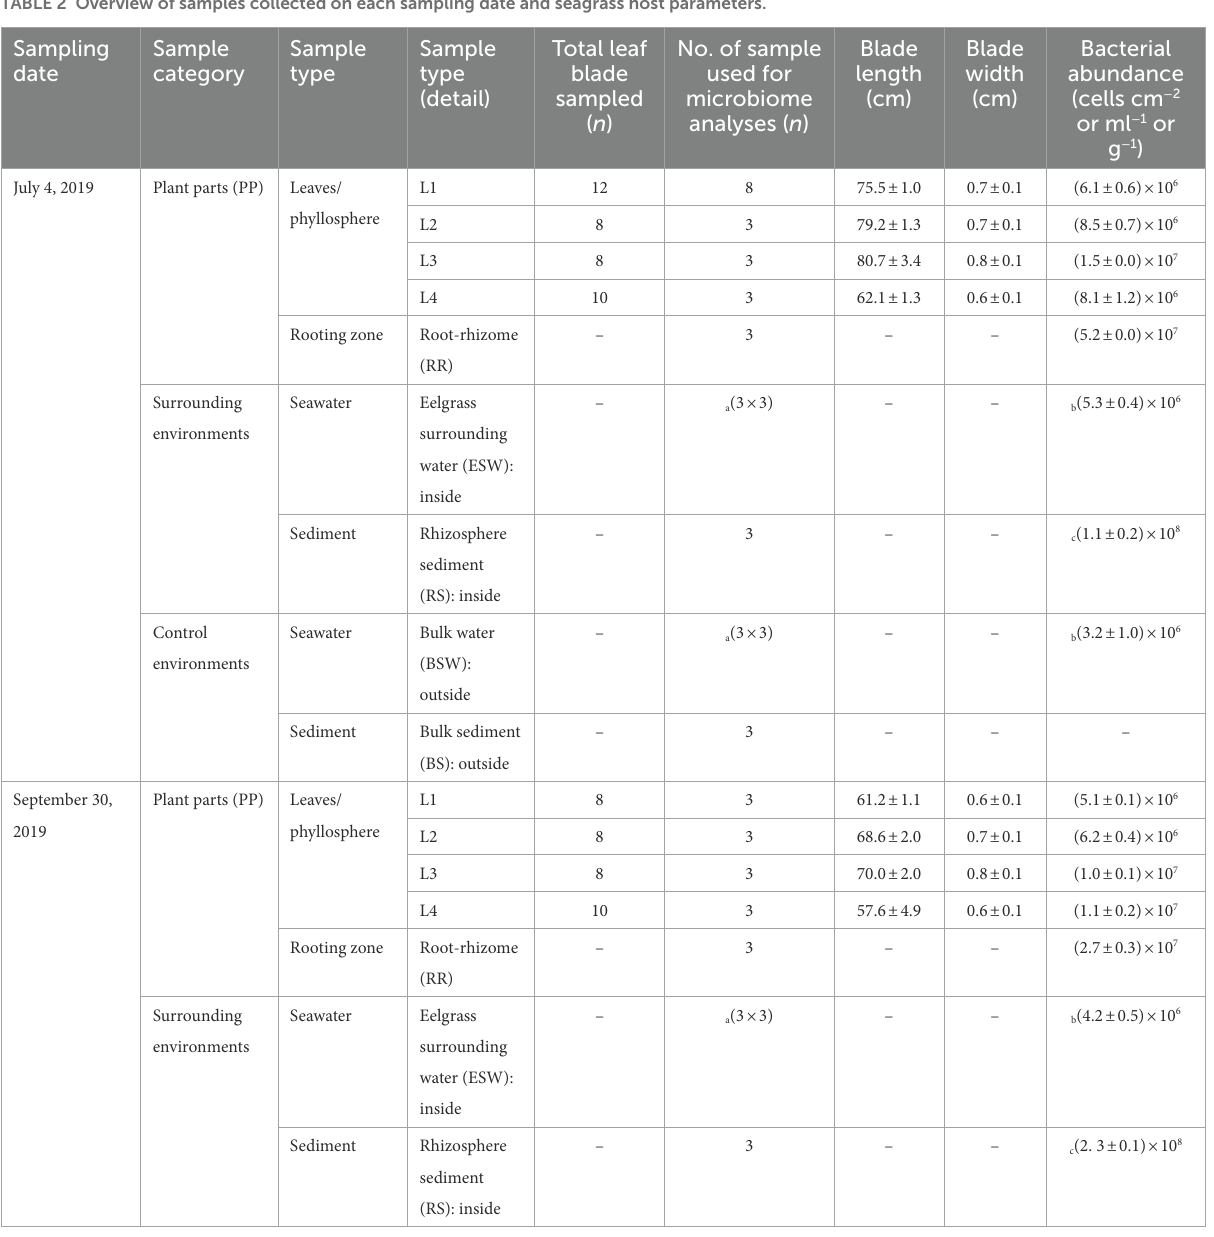
TABLE 2 Overview of samples collected on each sampling date and seagrass host